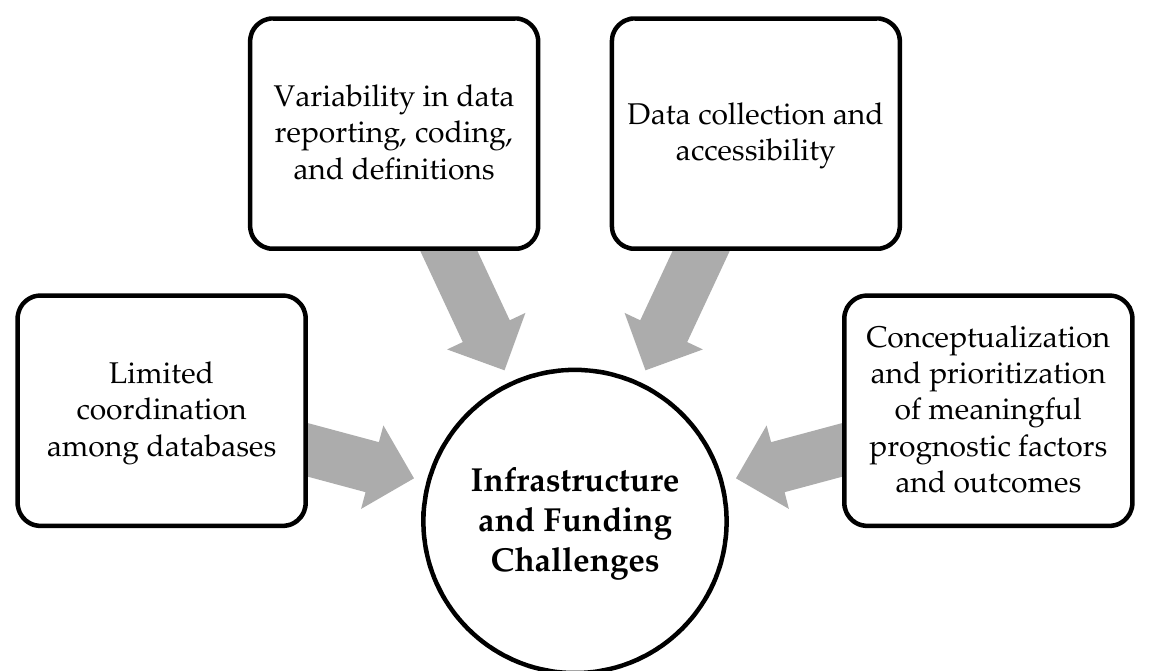
Figure 1. Four identified barriers related to infrastructure and funding challenges, including (1) data collection and access; (2) variability in data reporting, coding, and definitions; (3) limited coordination among databases; and (4) conceptualization and prioritization of meaningful prognostic factors and outcomes.